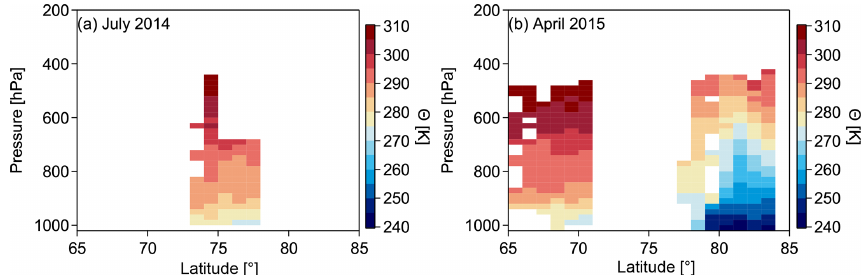
Figure 5. Potential temperature (cid:50) as a function of latitude and pressure binned in steps of 1 ◦ latitude and 20hPa pressure for July 2014 (a) and April 2015 (b) . Note the dome-like structure during April 2015 (NETCARE 2015), which is virtually absent for the Resolute Bay data during July 2014 (NETCARE